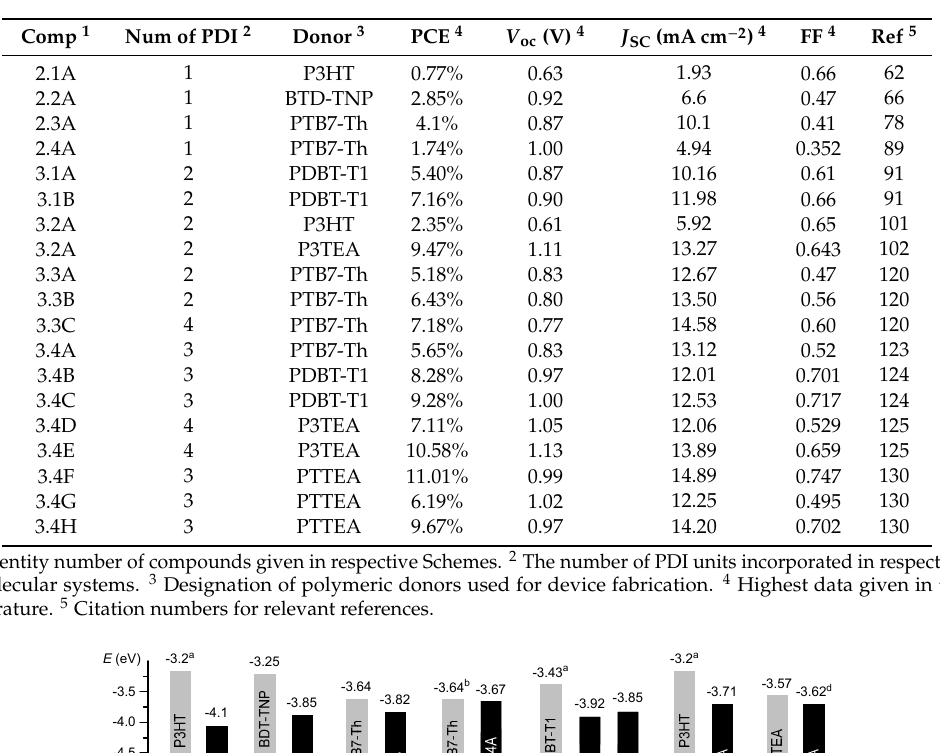
Table 1. Summary of information on PDI materials and photovoltaic records in OSCs.